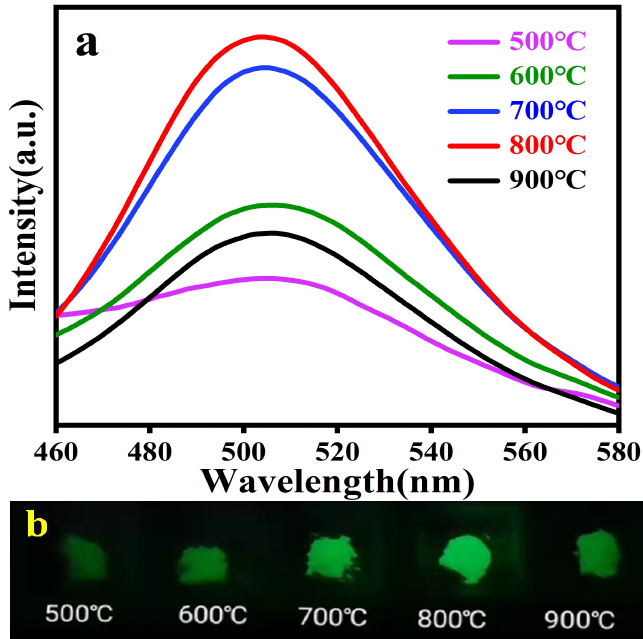
Figure 4. ( a ) PL emission spectrum of samples were excited at 365nm; ( b ) Luminescence of tempera- ture control group under 365 nm UV lamp